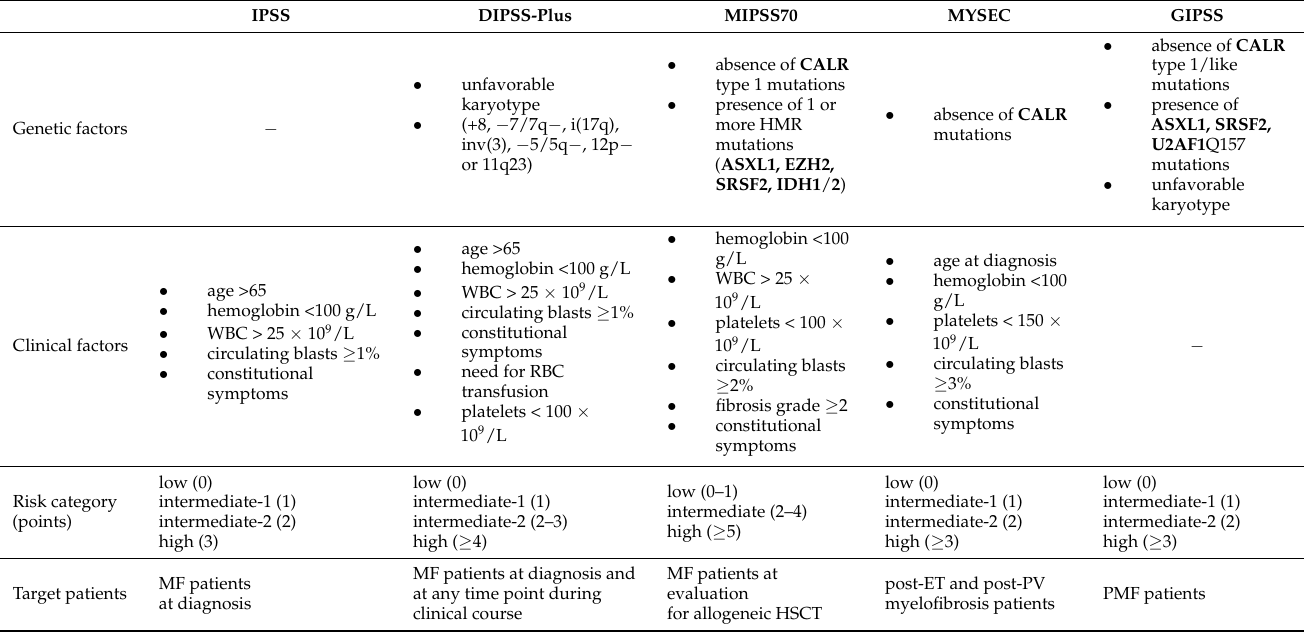
Table 1. Risk stratification schemes for myelofibrosis involving clinical and genetic factors.